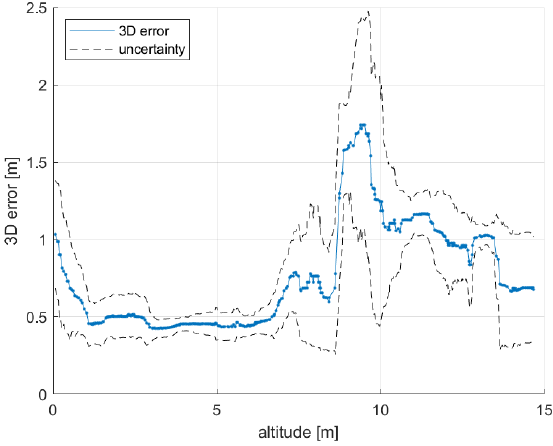
Figure 9. 3D positioning error varying the drone altitude (Gauss-Newton algorithm based estimates).